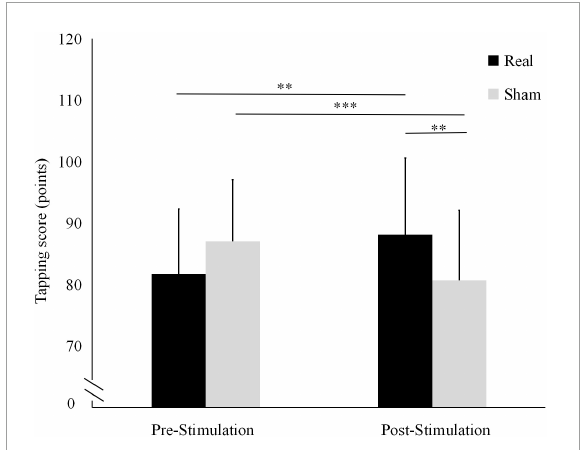
FIGURE3 Differences in tapping scores before and after the real and sham stimulation sessions. *** P < 0.001, ** P < 0.01.